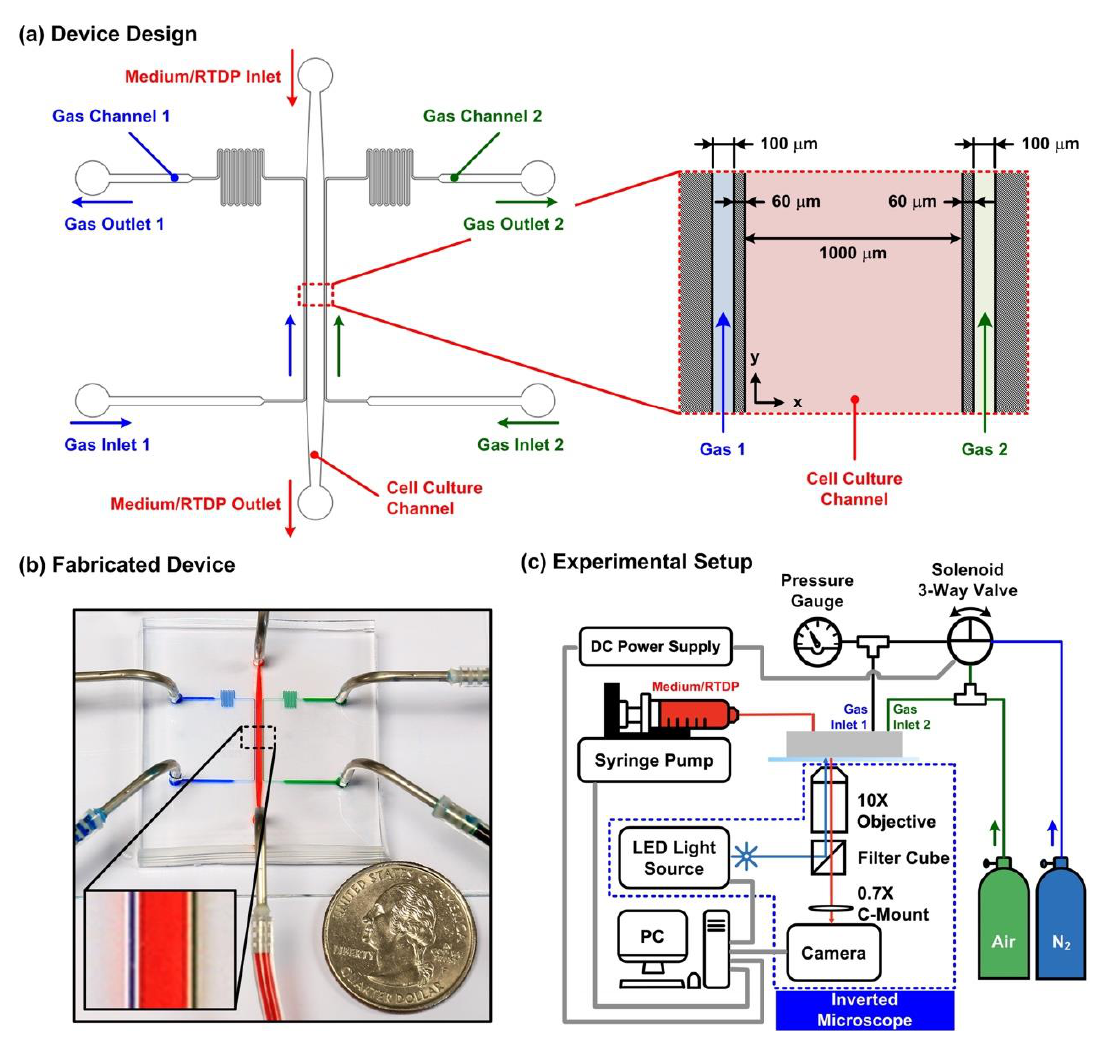
Figure 1. ( a ) Schematic of the PDMS microfluidic device capable of generating cyclic oxygen gradients. Three sets of microfluidic channels were designed in the device, including the middle cell culture channel and two side channels for oxygen gradient generation. The channels are separated by 60 µ m-wide walls. Oxygen gradient in the cell culture channel is generated by purging pure nitrogen gas and air into the left (Inlet 1) and right (Inlet 2) side channels, respectively. ( b ) Experiment photos of the fabricated device filled with food dyes. ( c ) Experiment setup for generation of the cyclic oxygen gradients using the microfluidic device for cell culture experiments and observation.